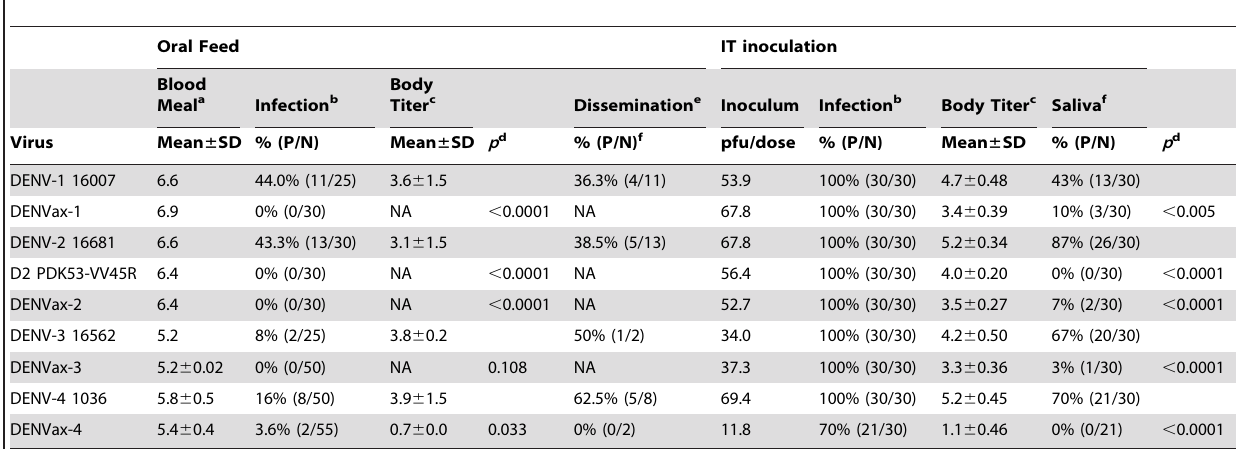
Table 4. Virus infection, dissemination, and transmission rates in whole mosquitoes.